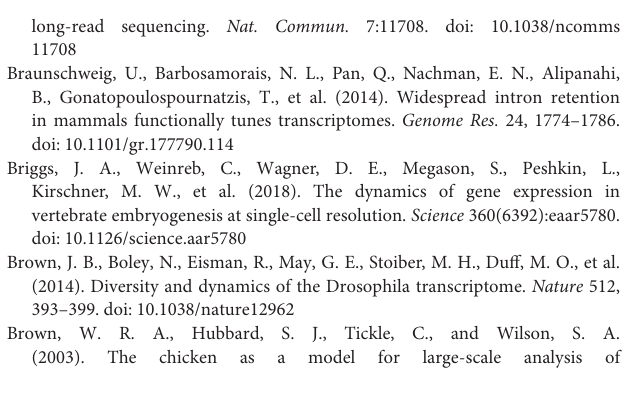
Table S4 | List of enriched GO terms for different gene clusters (XLS